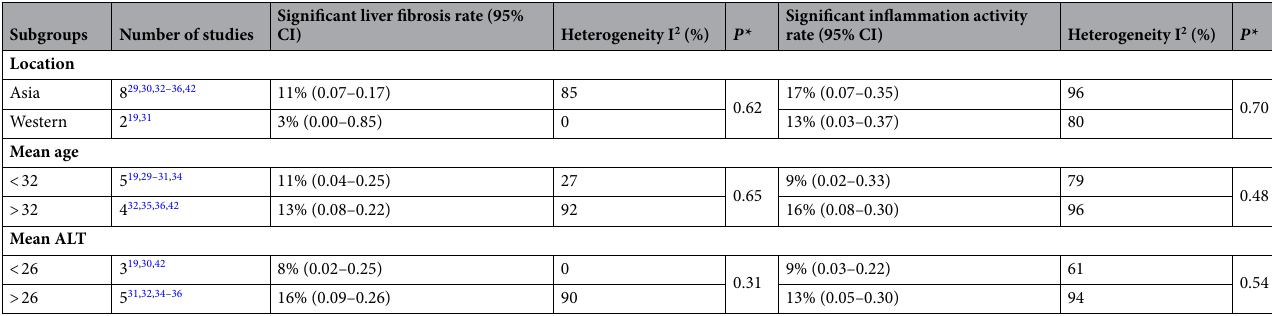
Table 3. Rate of significant histologic changes according to baseline demographic and clinical characteristics. *Heterogeneity between